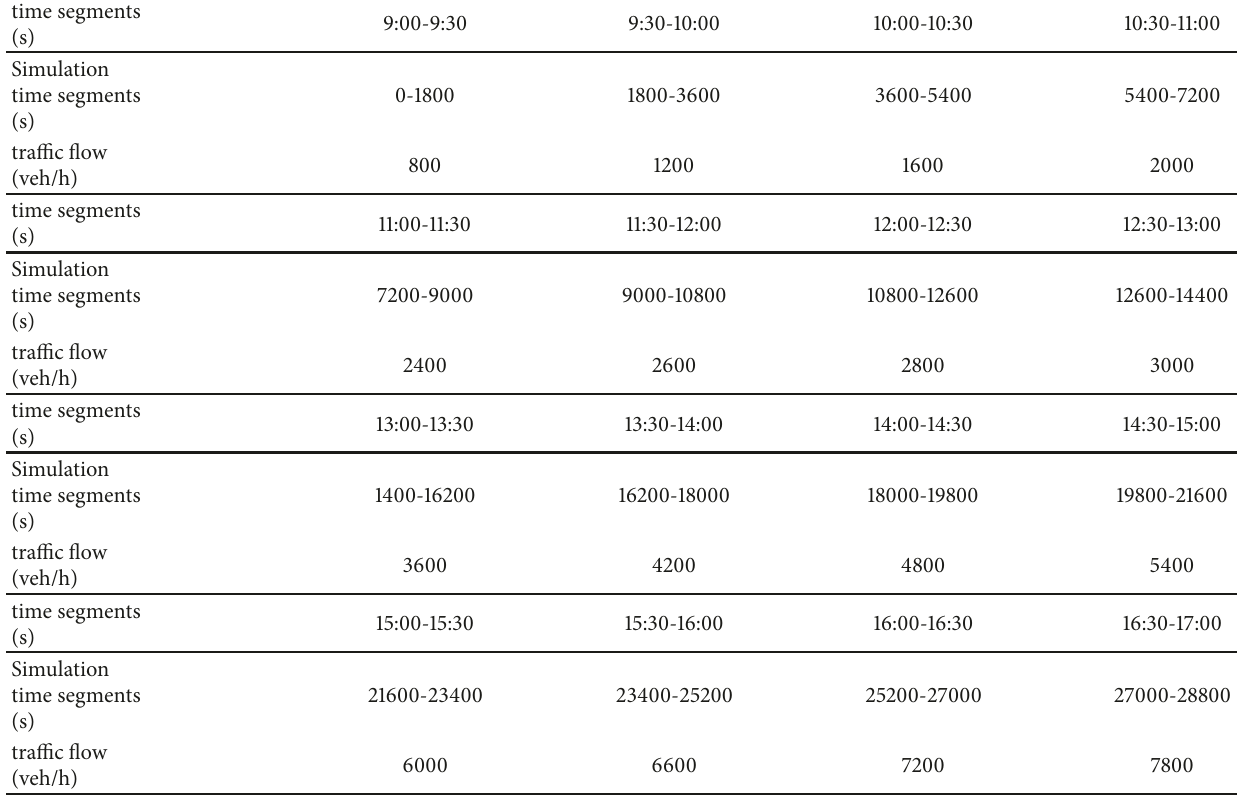
Table 1: The input traffic